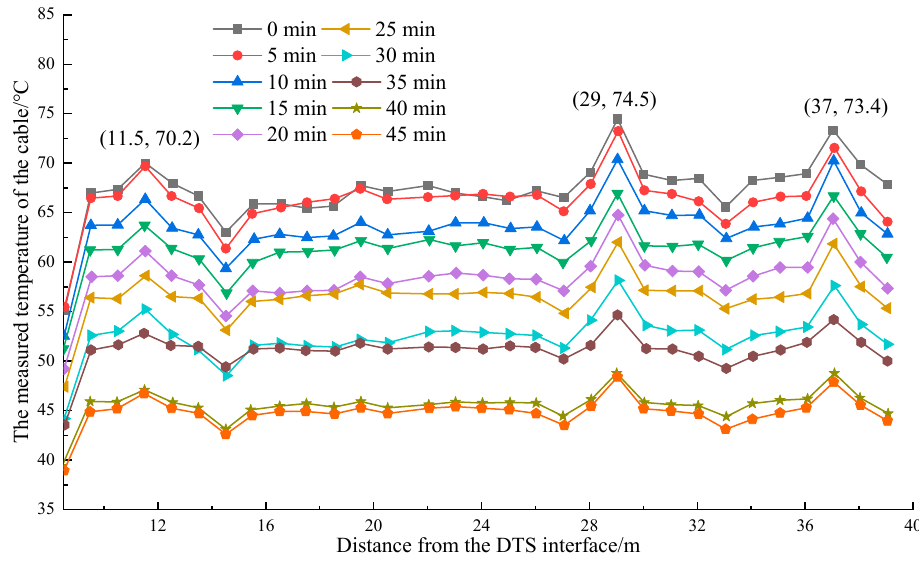
Figure 12. Variation curve pipe temperature.